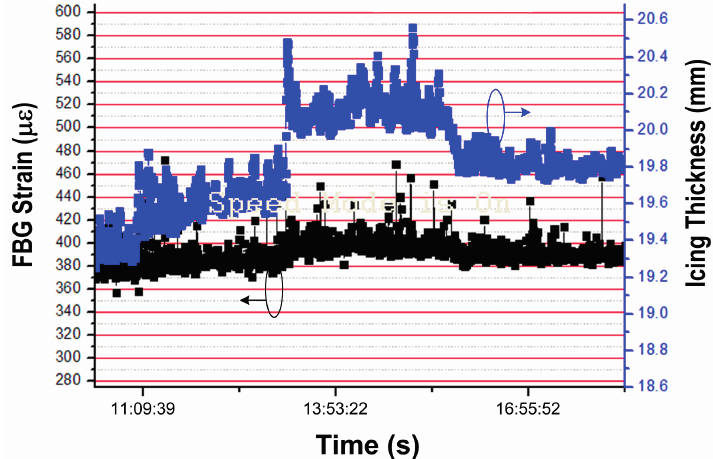
Figure 13. Experimental results of FBG strain and icing thickness through modified demodulation approach with consideration of the